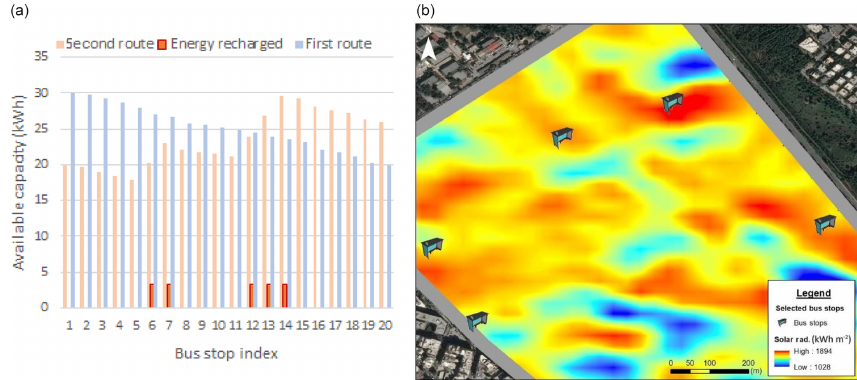
Figure 3. (a) Energy consumption and recharging route profile. (b) The five selected bus stops receiving the highest solar radiation amount (Base Map Layer: Bing Map v.7, Bing Satellite Base Map).